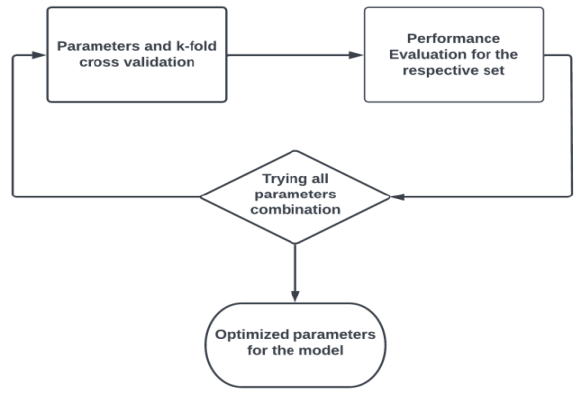
Figure 6. Workflow of